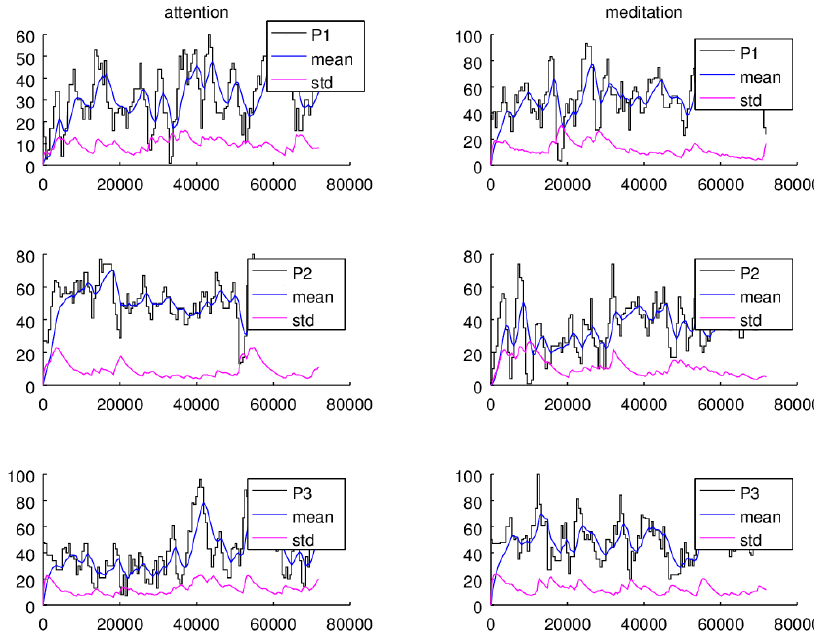
Figure 10. Statistic, average and standard deviation, computations of the attention and meditation signals of the individuals P1 , P2 , and P3 .